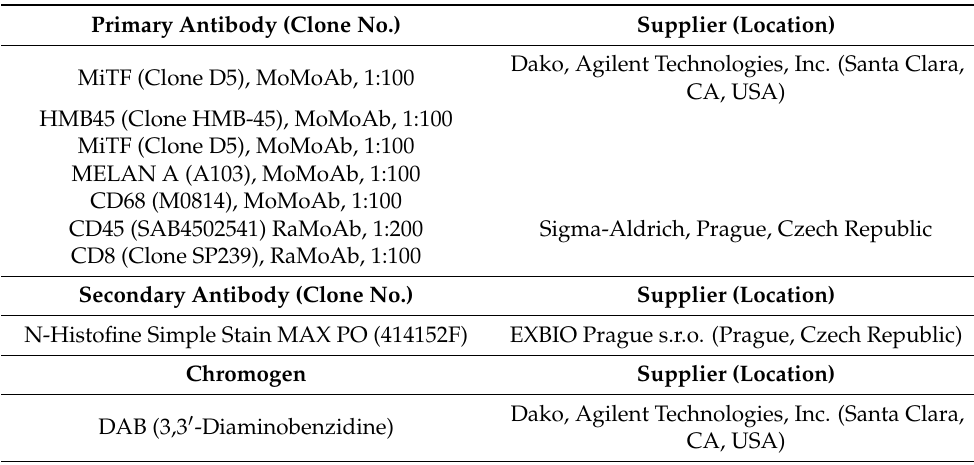
Table 2. Antibodies used for immunohistochemical